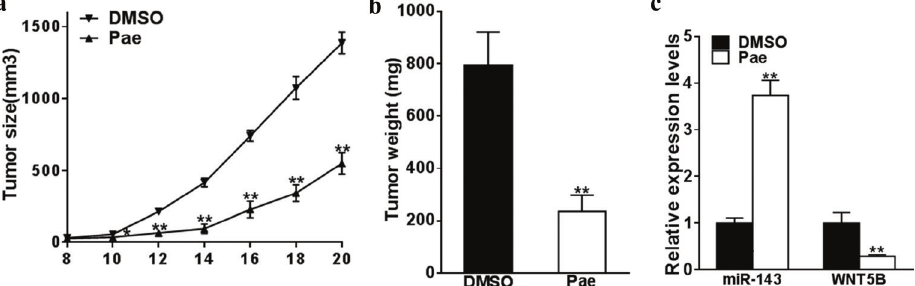
Fig. 5 . Paeonol (Pae) suppresses tumor formation of melanoma in vivo . M14 cells were suspended in serum-free 1640 (1 × 10 6 ), and were injected in the posterior flank of the nude mice. After 8 days, the mice were treated with 100 mg/kg Pae or DMSO (each group with 4 mice) by tail intravenous injection. (a, b) The tumors were measured every 2 days until day 20, and were excised, photographed and weighed (Scale bars = 10 mm). (c) The expression levels of miR-143 and WNT5B of tumors were analyzed by qRT-PCR. ** P < 0.01 versus